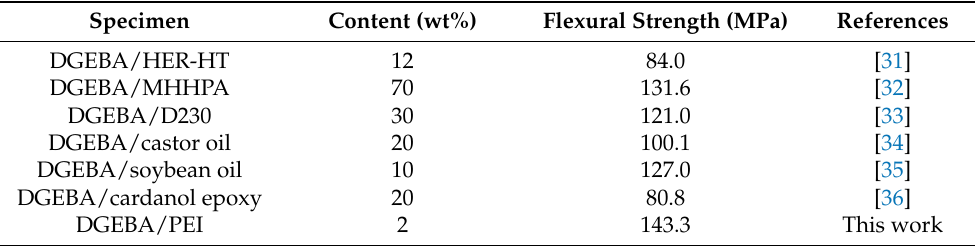
Table 2. Comparisons of DGEBA-based blends in flexural